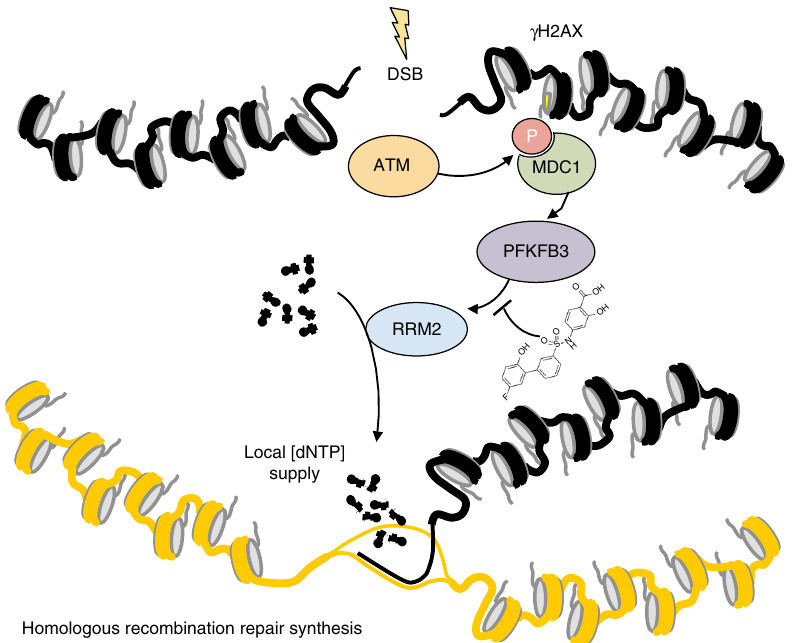
Fig. 7 PFKFB3 mediates ATM-dependent break-induced dNTP supply. MRE - ATM- γ H2AX-MDC1 signaling recruits PFKFB3 into nuclear foci, within the DNA damage response upon IR. PFKFB3 activity is required for subsequent recruitment of the RRM2 subunit of ribonucleotide reductase to sites of DNA damage to potentially generate a local dNTP pool. Inhibition of PFKFB3 activity impairs IR-induced repair synthesis, homologous recombination, and replication fork progression, which is restored by nucleoside